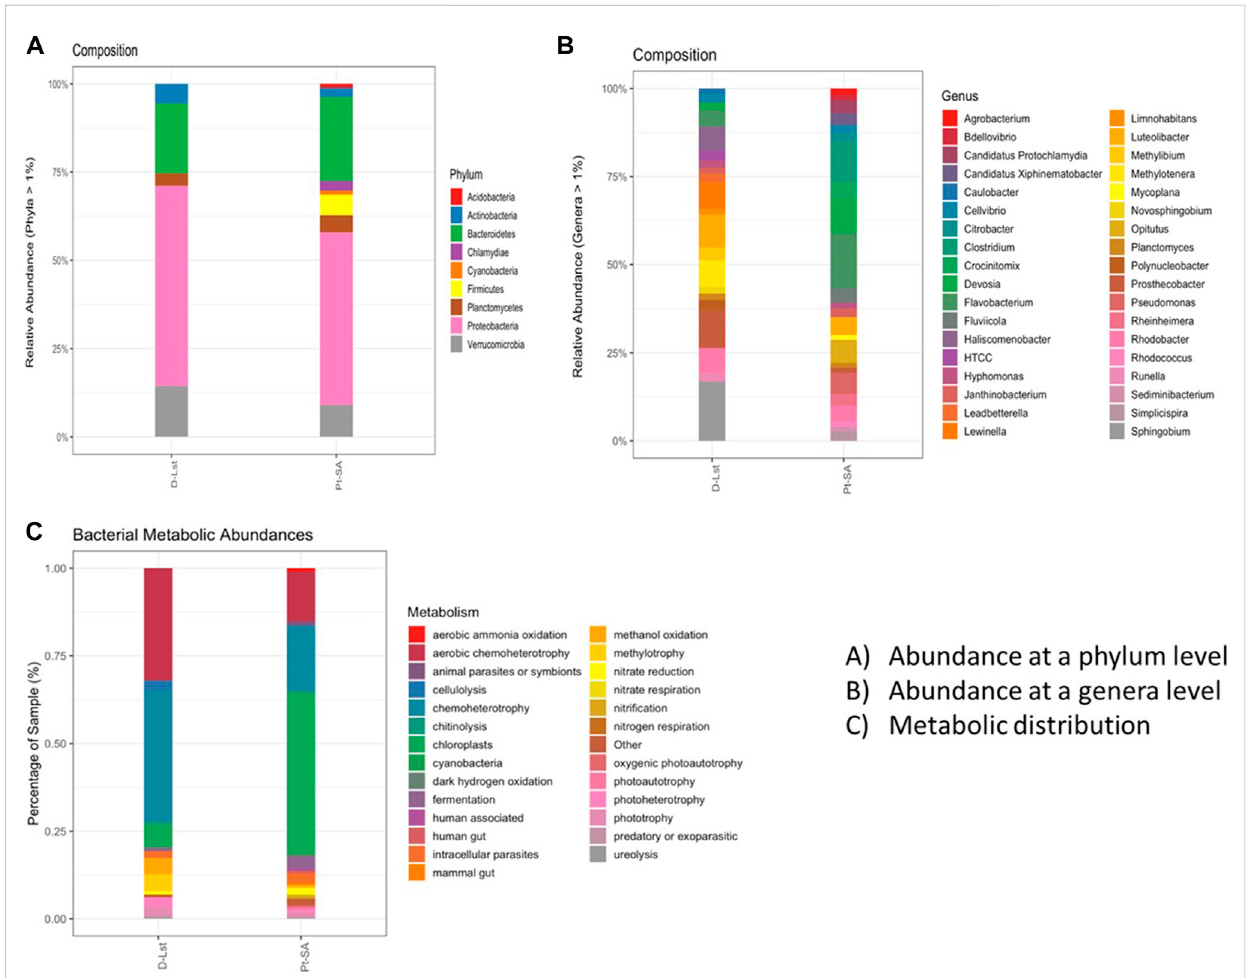
FIGURE 1 Taxonomic distribution and characteristics of bacterial communities in the D-Lst and Pt-SA samples: (A) Microbial relative abundance on a phylum level. (B) Microbial relative abundance on a genera level. (C) Functional annotation of OTUs, using FAPROTAX, of metabolic abundances from the two wastewater